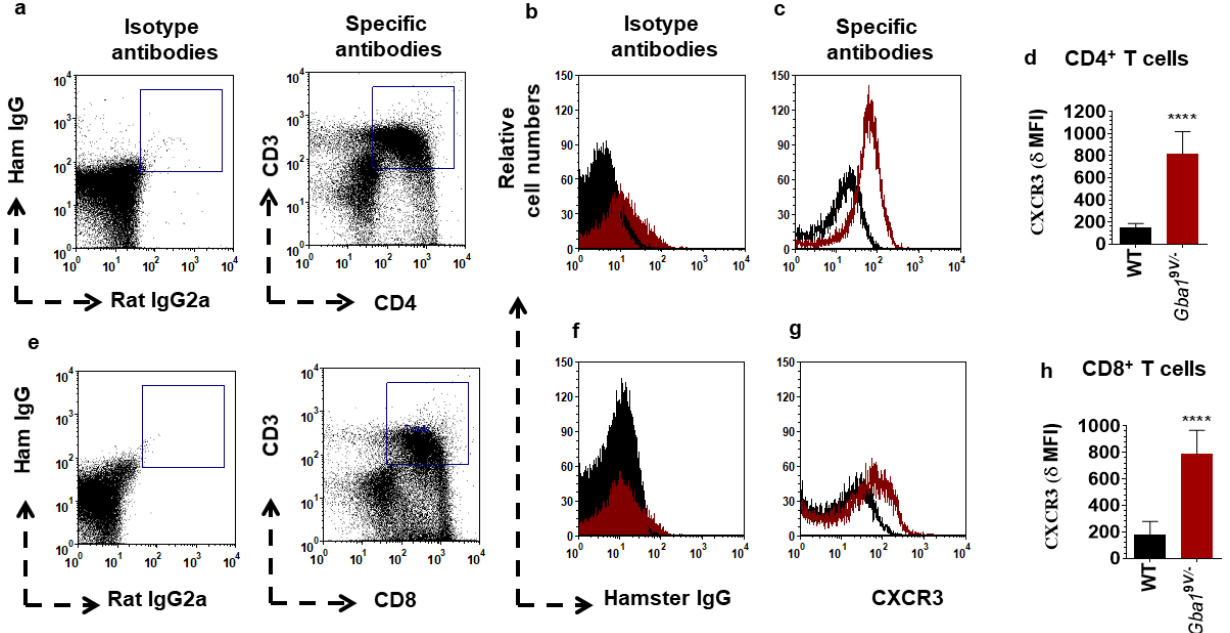
Figure 2. CXCR3 surface expression in pulmonary T cell subsets from Gba1 9V/- mice. CXCR3 expression in FACS-sorted CD3 + CD4 + T cells ( a – d ) and CD3 + CD8 + T cells ( e – h ) from lung of strain-matched Gba1 9V/- and WT mice ( n = 5/group). δ MFI: CXCR3 MFI—isotype MFI. In the dot plots of isotypes and specific antibodies ( a , e ), in the histograms of isotypes ( b , f ), specific antibodies ( c , g ), and the bar diagrams ( d , h ), the black lines/columns correspond to WT and the maroon lines/columns to Gba1 9V/- mice. Values in d and h are the means ± SD. and asterisks show significant differences between WT and Gba1 9V/- mice (**** p < 0.0001). Three independent experiments were conducted, and groups were compared using student’s t -tests.